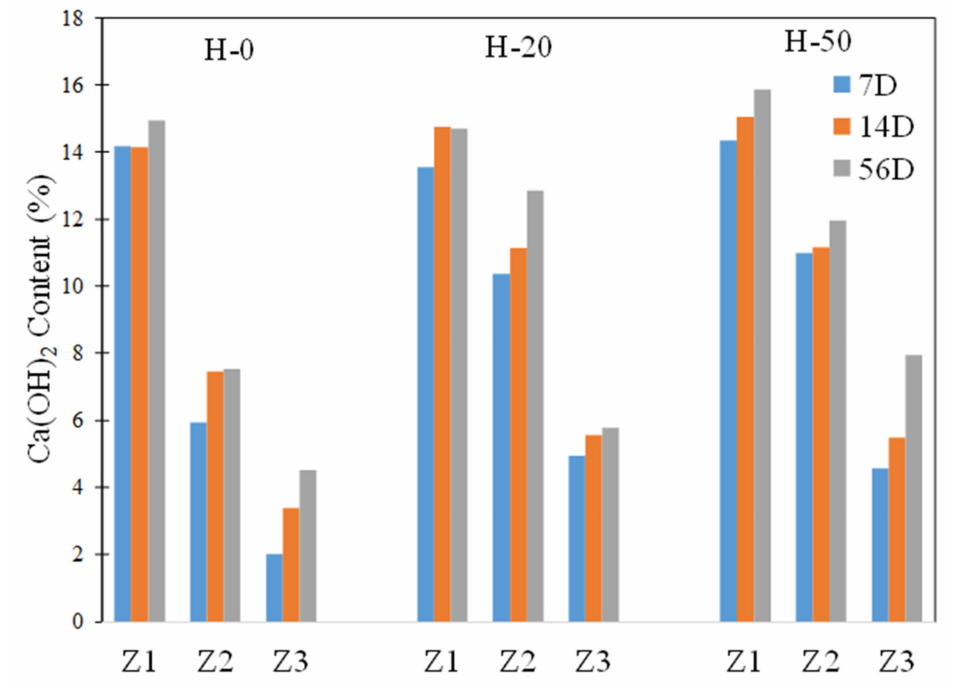
Figure 8. Ca(OH) 2 content in zones, Z1, Z2, and Z3, surrounding the